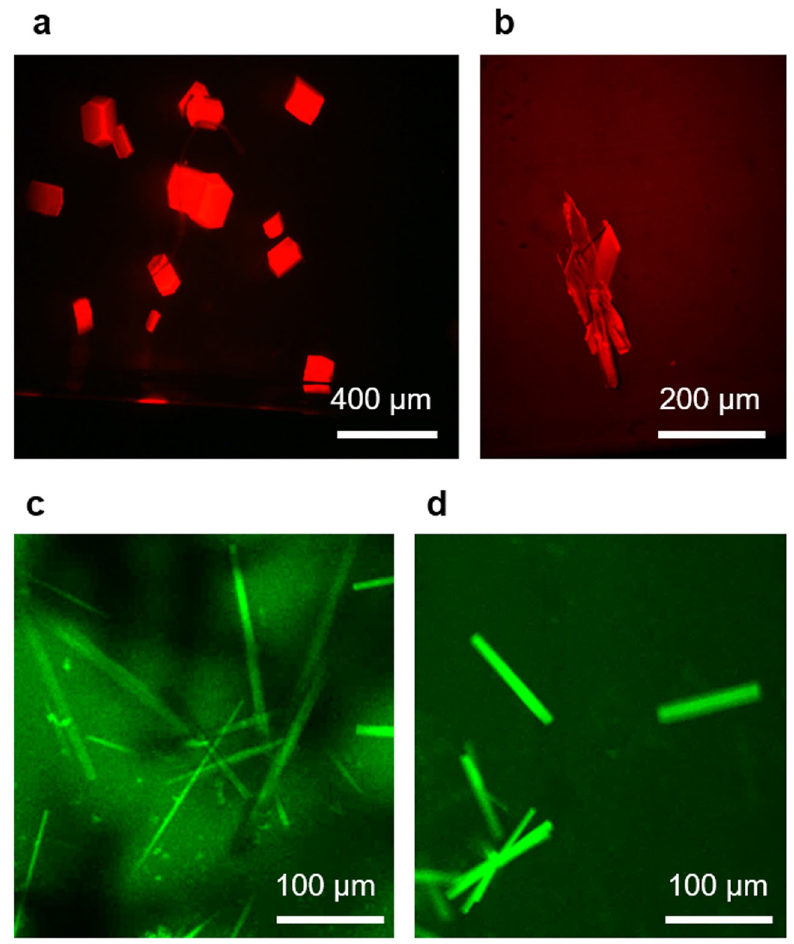
Fig. 5 Representative confocal fl uorescence micrographs. a Lysozyme and b BSA crystals in the presence of 5% dimer of the respective protein labeled with Alexa Fluor 594 NHS ester grown at 1 G. Representative Pf GST crystals were grown in the presence of c 1% tetramer impurity and d 5% tetramer impurity labeled with Alexa Fluor 488 TFP ester and the displayed crystals were also prepared under unit gravity conditions. The crystals from the capillaries utilized for further investigation were similar in size, which means ~180 – 220 µm in major